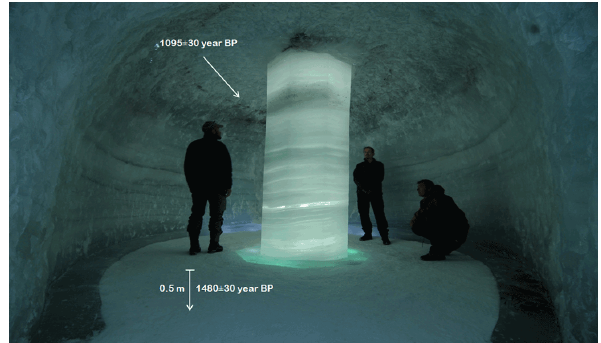
Figure 15. Photo from the old ice tunnel excavated in 2010 showing the layering in the ice and position of two samples for radiocarbon dating. Photo: Klimapark2469